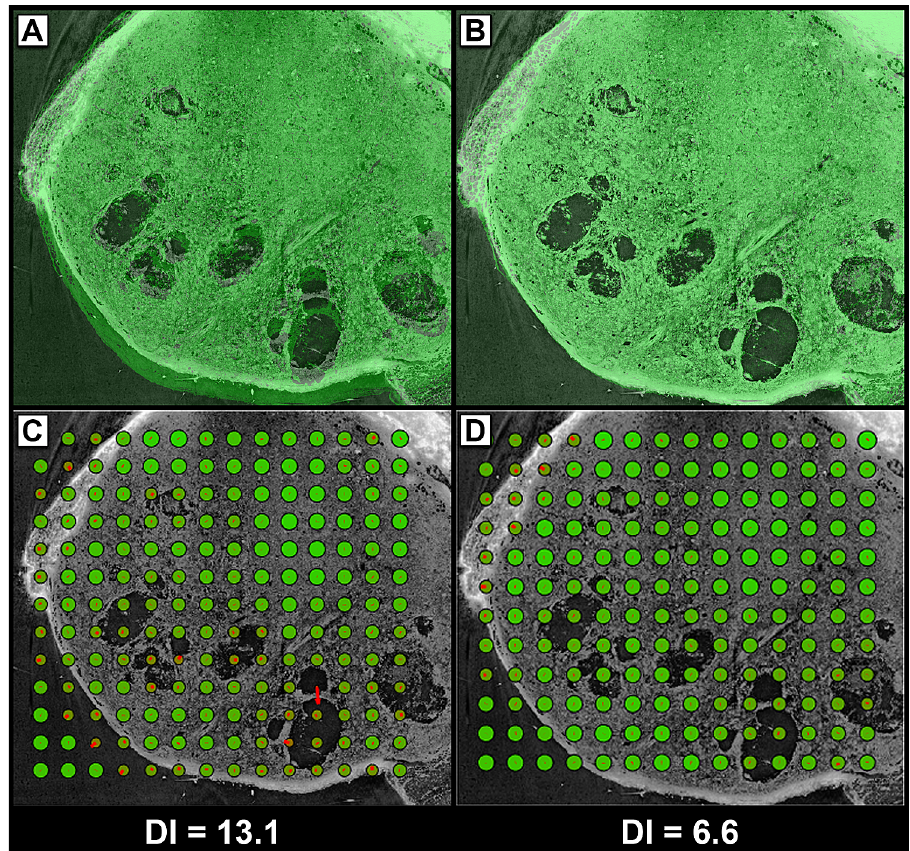
Figure 3. Evaluation of the registration quality using the ‘Displacement Index’. Representative CT (grey) and corresponding MTS (pseudo-coloured in green) images from a mouse breast cancer tissue. ( A ) Overlay of the CT image with the MTS histology image before transformation. ( B ) The same images after using the matching pipeline. ( C ) DI calculation of both images before matching (DI = 13.1). The congruence between each CT tile and histology tile is directly proportional to the size of the green circle inside that tile. The red lines show the calculated displacement of each tile. ( D ) DI calculation of both images after matching (DI =